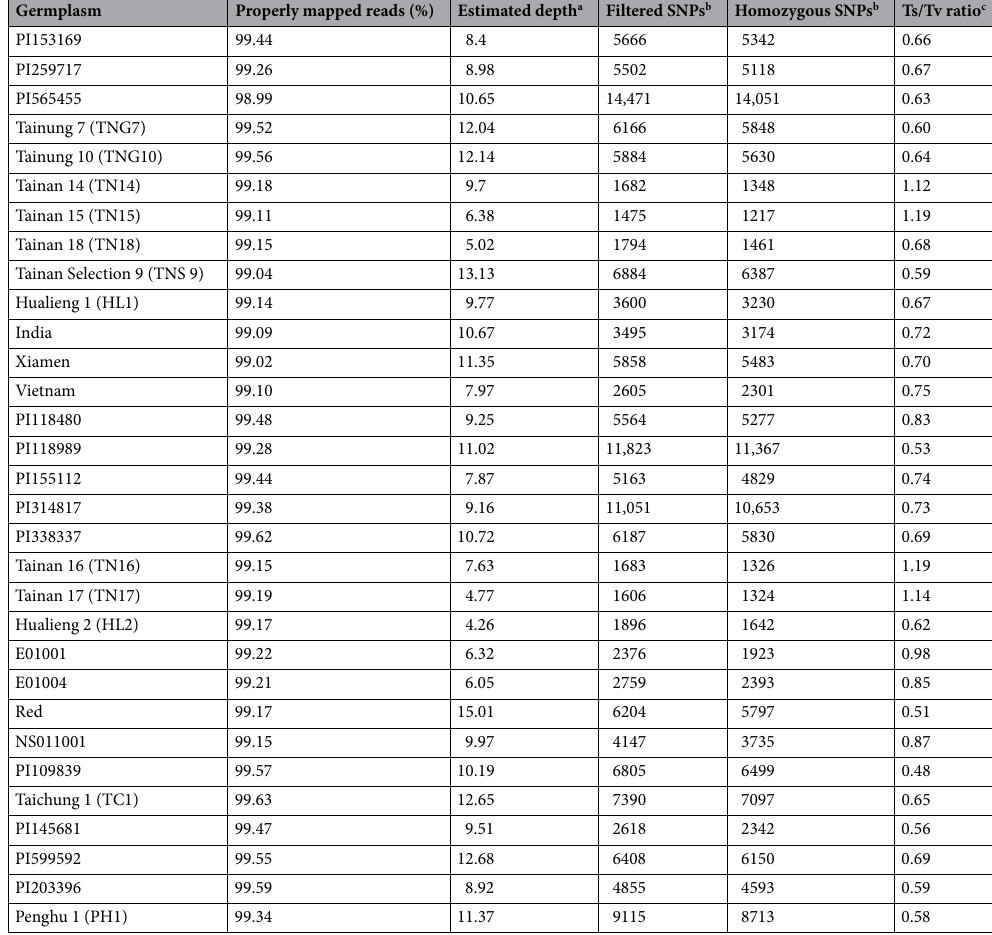
Table 1. Sequence and SNP information of our 31 accessions in the Taiwanese peanut germplasm. a The estimated depth was calculated by the total number of bases divided by 4.8% of 2.7 Gb, the size of reduced reference genome. b The SNP identification was based on the reference genome of A. hypogaea cv. Tifrunner. c Ts/Tv is the abbreviation of transition/transversion.